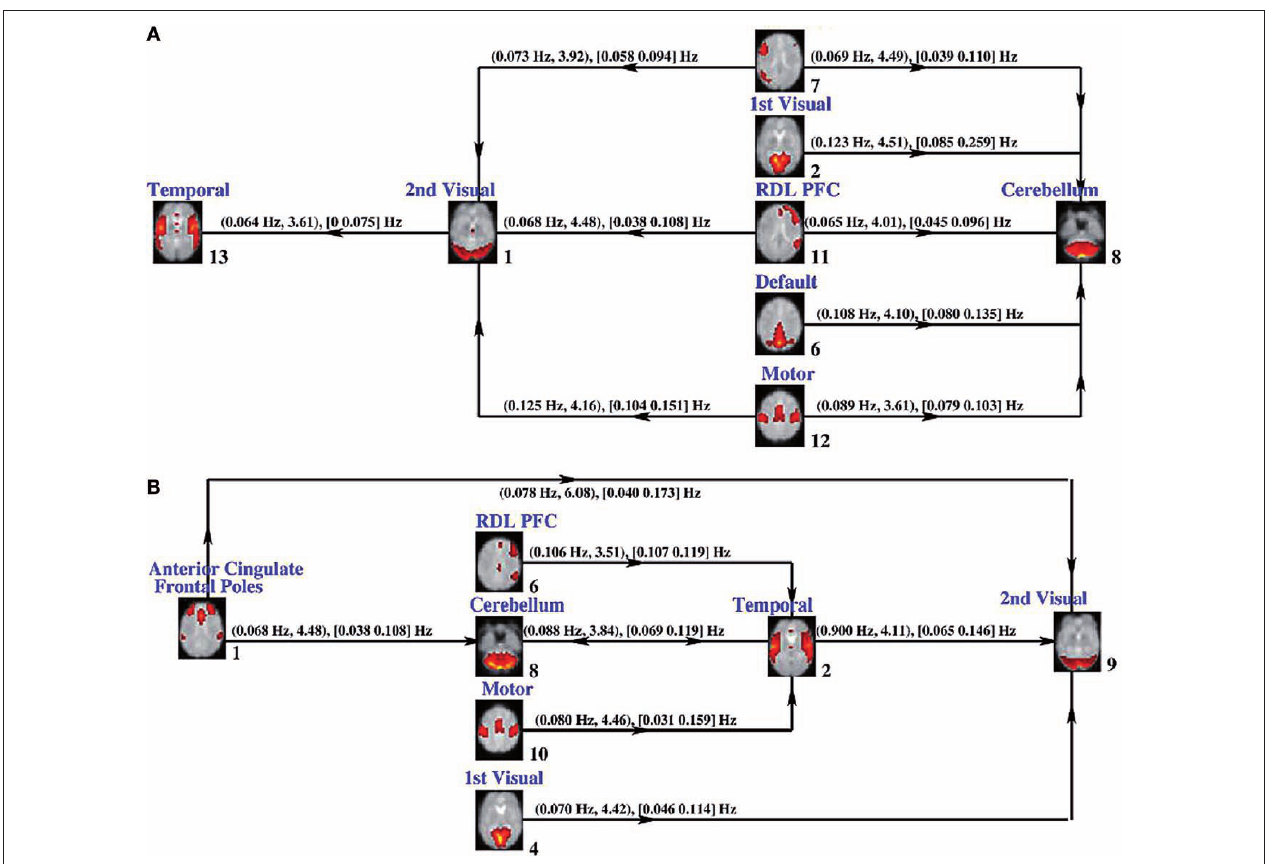
FIGURE 3 | Granger causality FNC results (from Demirci et al., 2009). Granger causality test results for SIRP data (A) and auditory oddball data (B) . The connections and their directions between brain networks are